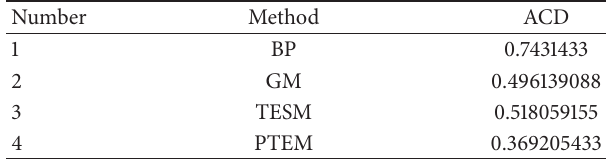
Table 2: The ACD results of each individual forecasting model.